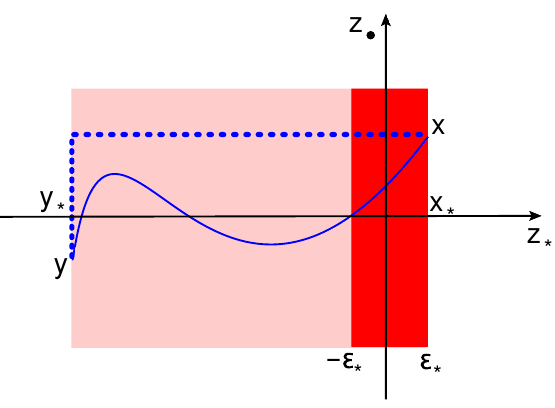
Figure 5 . Particle starts its propagation within the shock-wave. In this case the pure gauge is only to the left of the